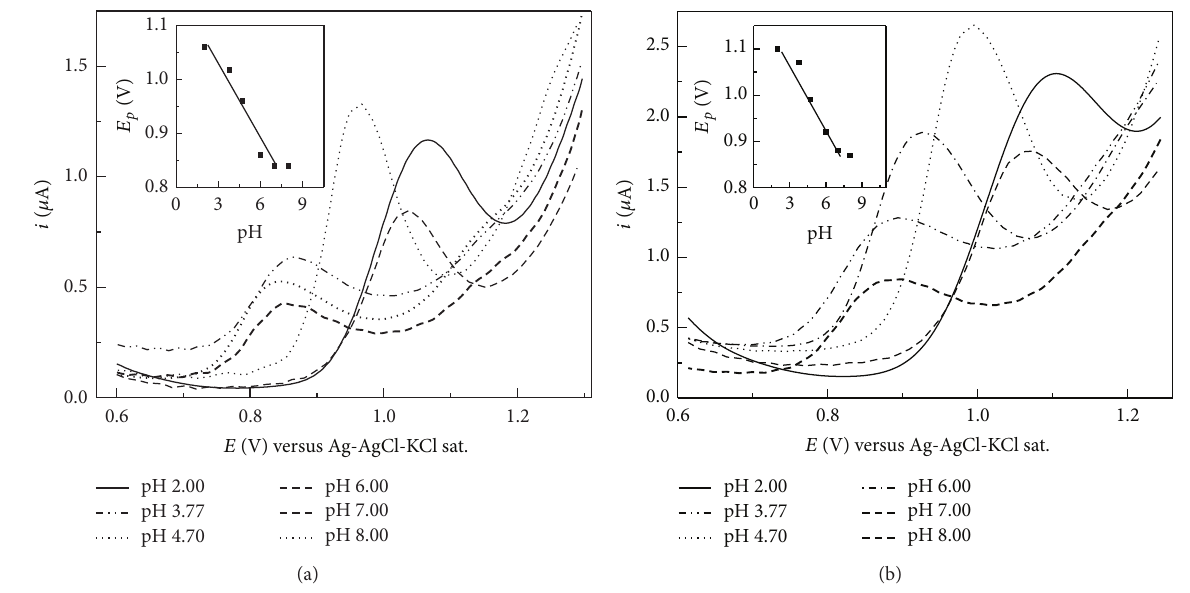
Figure 2: (a) Differential pulse and (b) square wave voltammetry and of 1.0 × 10 −5 M FXN in 0.2 M phosphate buffer solutions at different pH on GCE. Insets: 𝐸 𝑝 versus pH plots. DPV conditions were pulse amplitude, 50 mV; pulse width, 50 ms; and scan rate, 20 mVs −1 and SWV conditions were pulse amplitude, 25 mV; frequency, 15Hz; and potential step, 4mV.